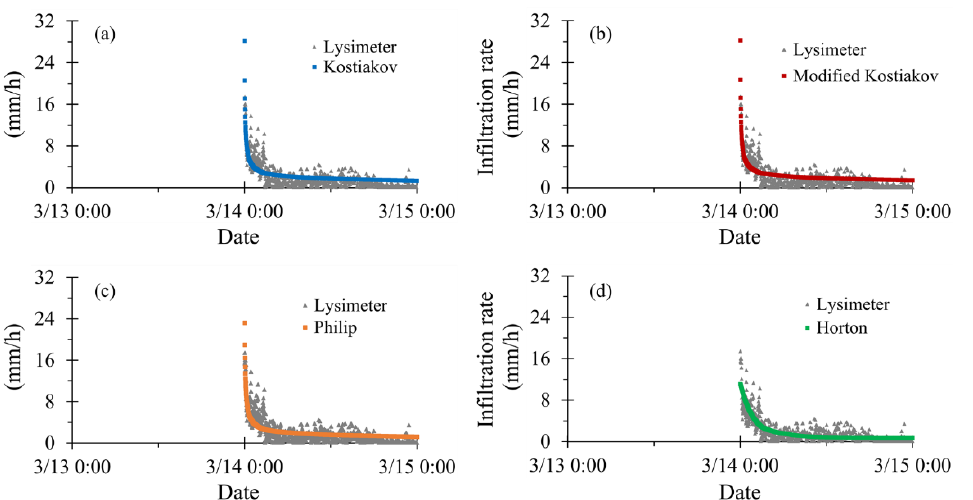
Figure 6. Adjustment of the infiltration models to the values of March 13 – 14, ( a ) Kostiakov model; ( b ) Modified Kostiakov model; ( c ) Philip model; ( d ) Horton model.